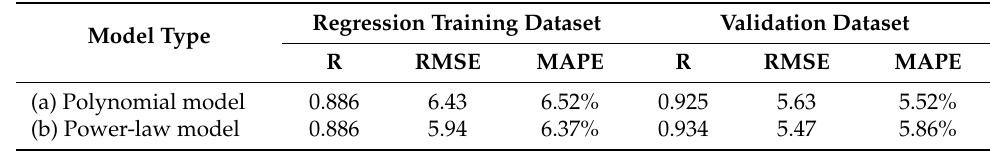
Table 8. Prediction performance of regression models.